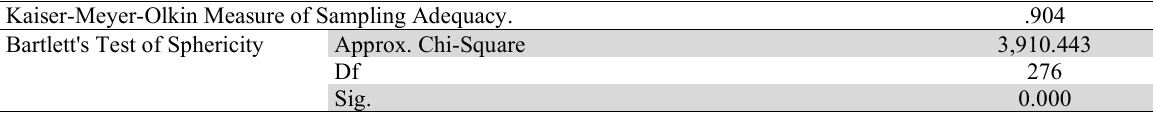
KMO and Bartlett's Test Kaiser-Meyer-Olkin Measure of Sampling Adequacy. .904 Bartlett's Test of Sphericity Approx. Chi-Square 3,910.443 Df 276 Sig. 0.000